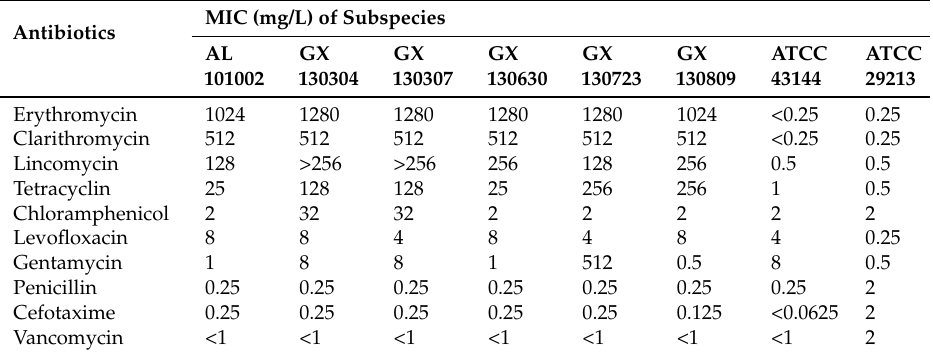
Table 1. Minimum inhibitory concentrations of six S. gallolyticus subsp. pasteurianus isolates.